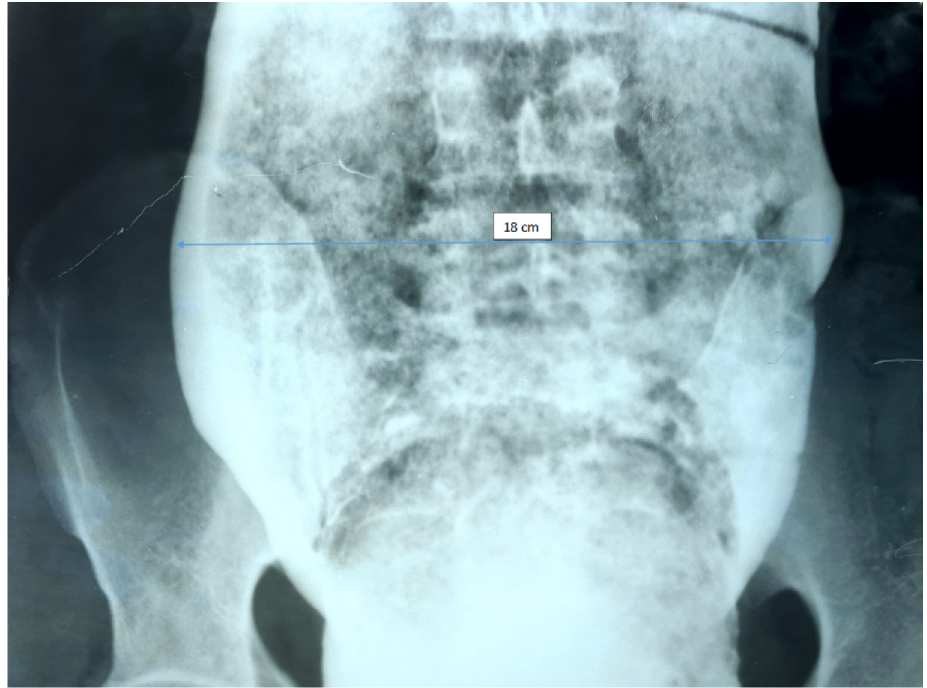
Figure 1. Irigographic examination — rectal evaluation sequence. Impressive dimensions of the rectum are found — about 18 cm diameter lumen, full of fecal matter, occupying the entire pelvis and compressing the adjacent viscera.